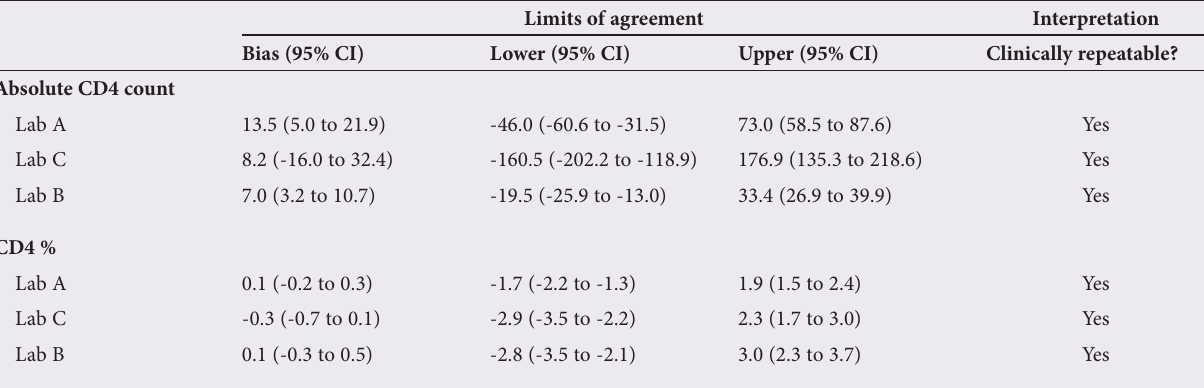
Table 2. Intra-laboratory bias and limits of agreement for CD4 count and CD4 percentage at 12 and 24 hours